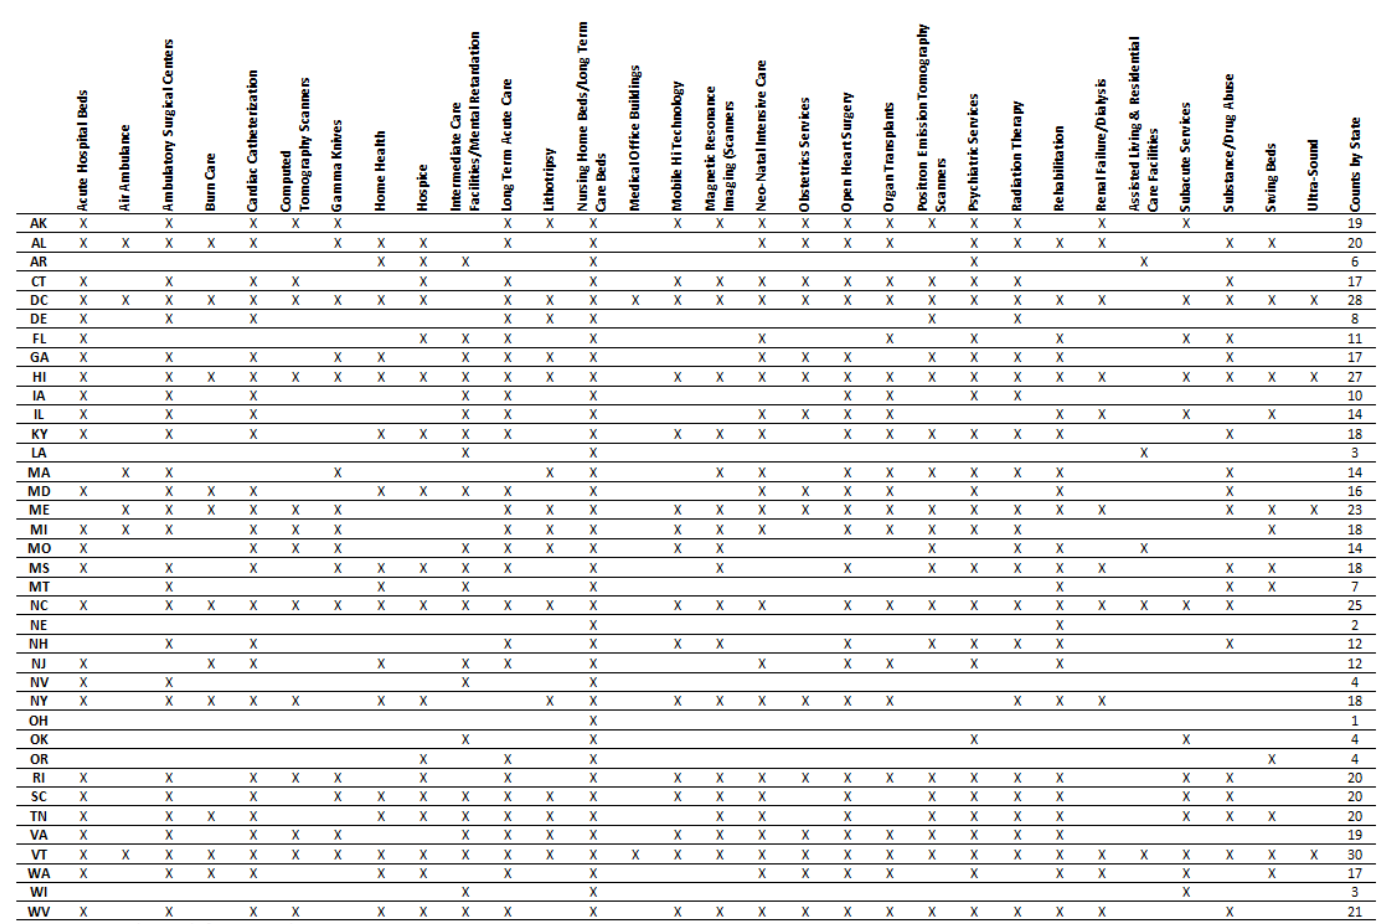
Figure 1. Certificate-of-need regulations in the United States. Source: National Conference of State Legislatures (NCSL (National Conference of State Legislatures)